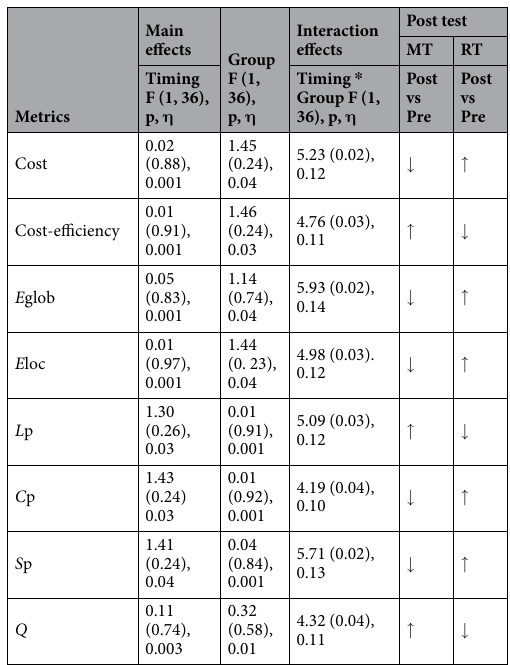
Table 2. Global network topology between Time (Pre/Post) and Group (Mediation training, MT, and relaxation training, RT). Note: η , effect size; n.s., no significant difference; ↑ ( ↓ ) compared with pre phrase, network metrics showed increased (decreased) trends after training